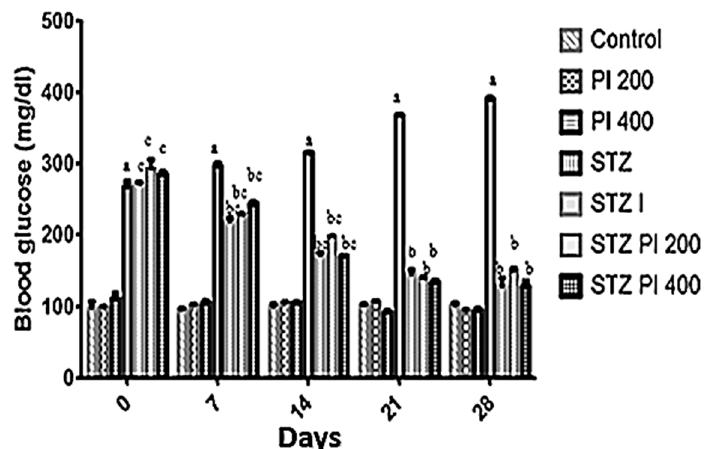
Figure 1. Changes in fasting blood glucose levels on weekly basis in experimental animals treated with protein isolate from Parkia biglobosa . Data in the figure above represents mean ± standard deviation, n = 10. a —compared with control, b —compared with streptozotocin (STZ) only, c —compared with treated non-diabetic groups. Values are statistically significant at p < 0.05.